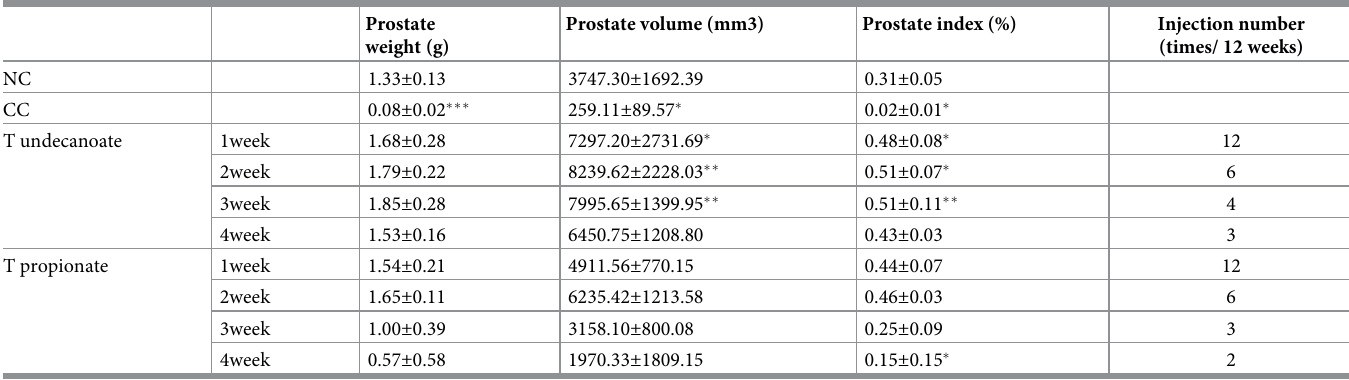
Table 3. Prostate measurements in the injection cycle substudy.